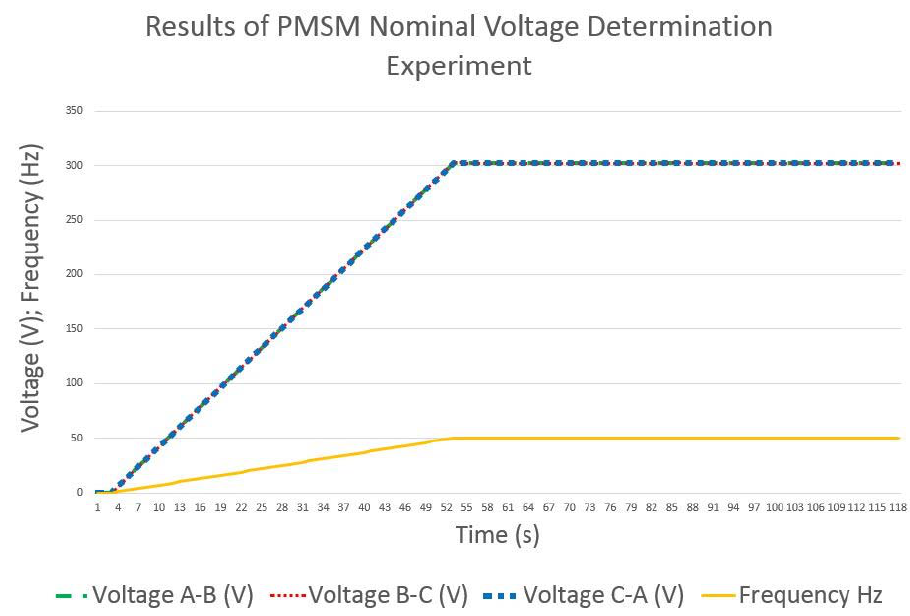
Figure 5. The results of voltage PMSM voltage determination experiment.